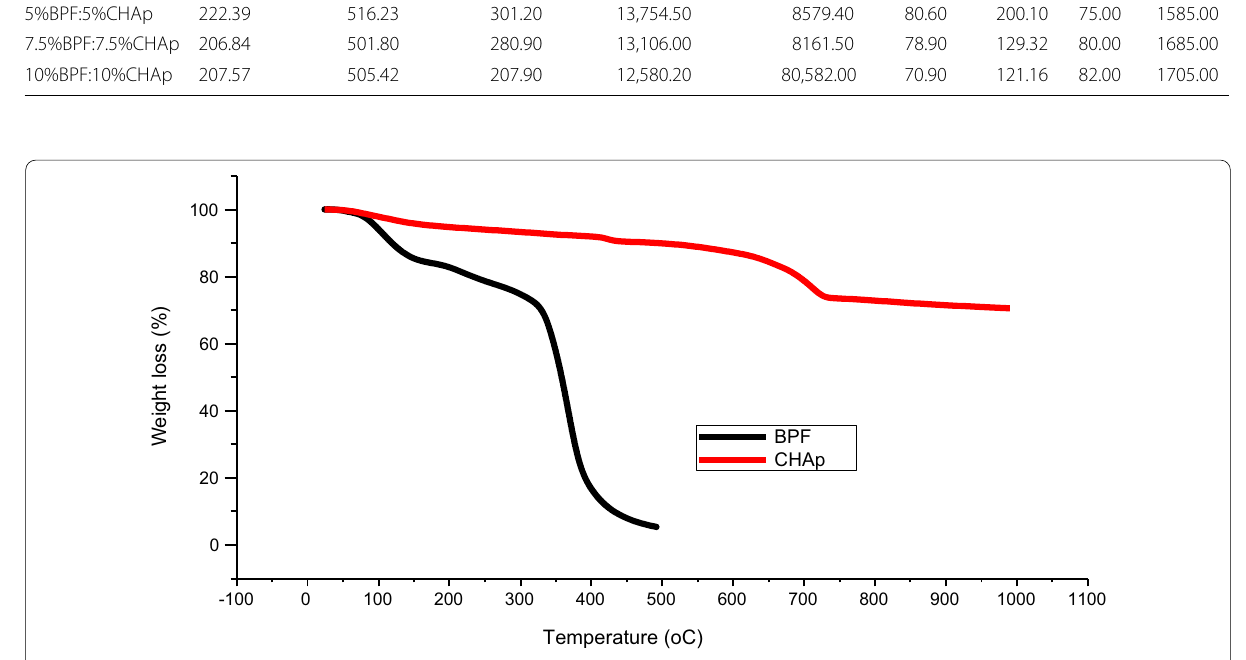
Fig. 5 TGA curves of the CHAp and